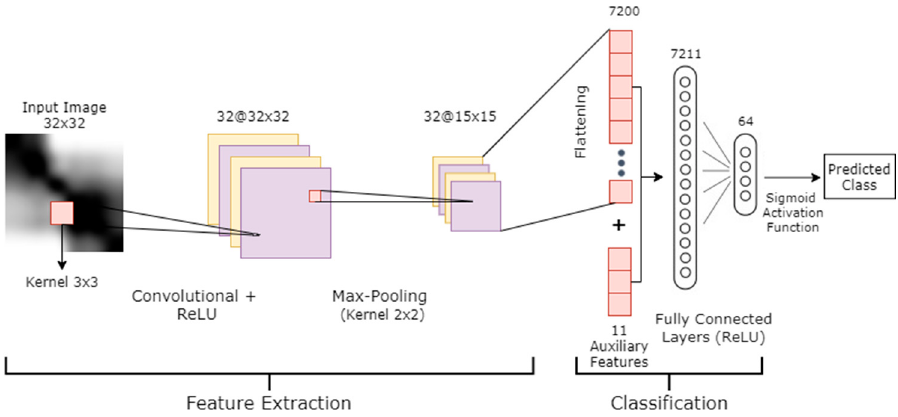
Figure 2. The image-CNN model architecture.